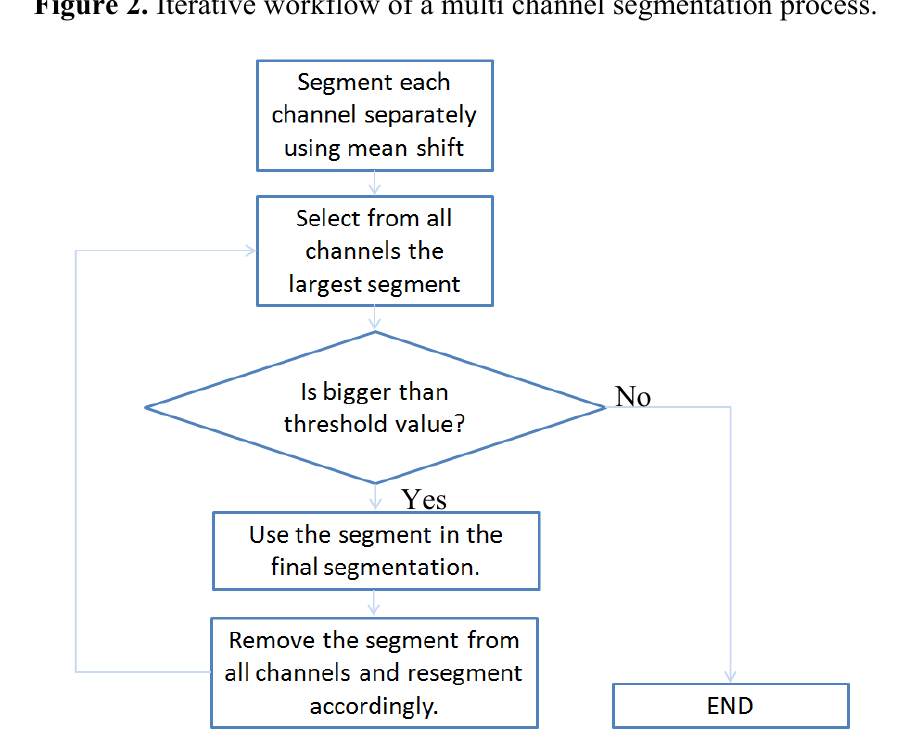
Figure 2. Iterative workflow of a multi channel segmentation